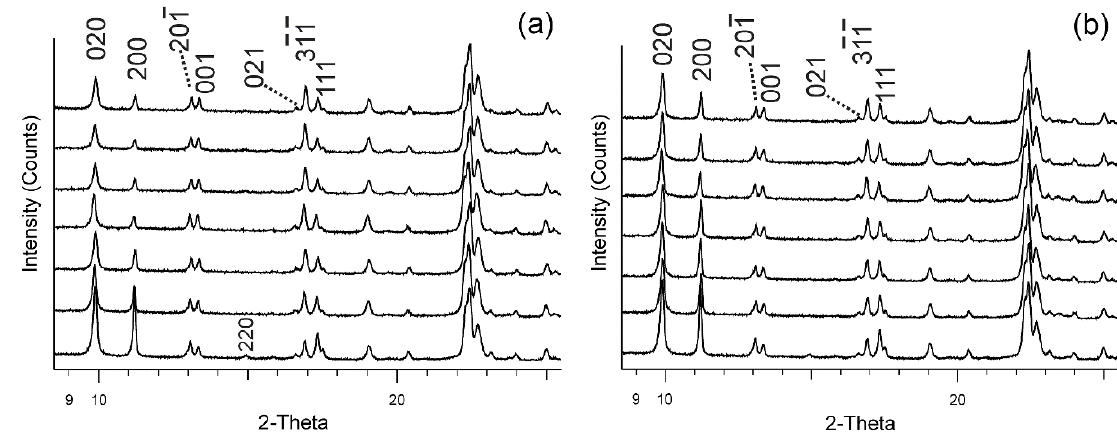
Figure 1. Powder XRD patterns of the purified clinoptilolite (bottom — left and right) and the Cd-exchange series of clinoptilolite at 90 °C ( a ) and RT ( b ) (from second pattern to top — 2 h, 24 h, 72 h, 168 h, 12 days, and 22 days of ion exchange process).